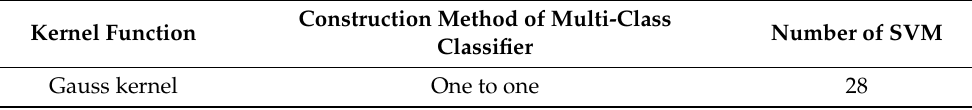
Table 7. Parameter setting of the SVM.